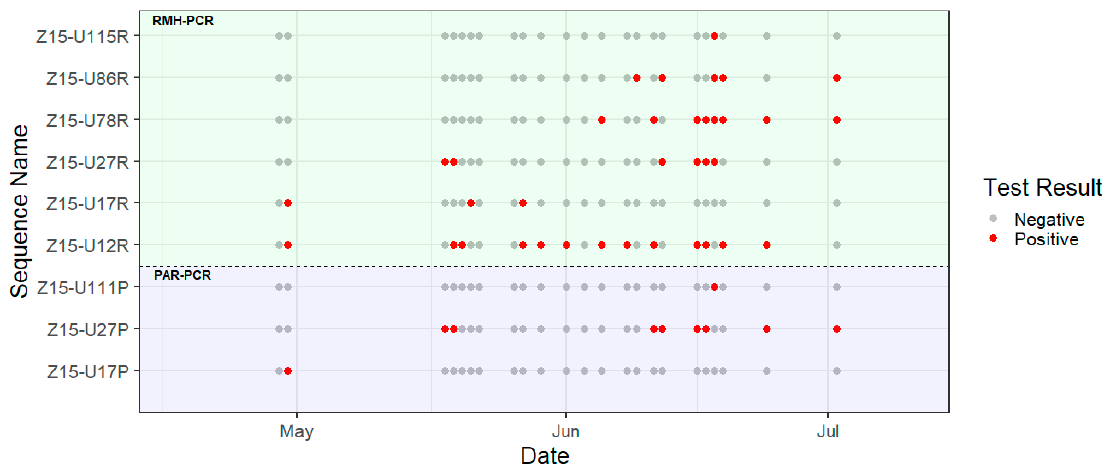
Figure 2. Timeline of amplicon sequences detected using the PAR-PCR (lower panel) and RMH-PCR assays (upper panel). The red dot denotes the positive amplicon sequence and the grey dot denotes the negative amplicon sequence detected at each time point.